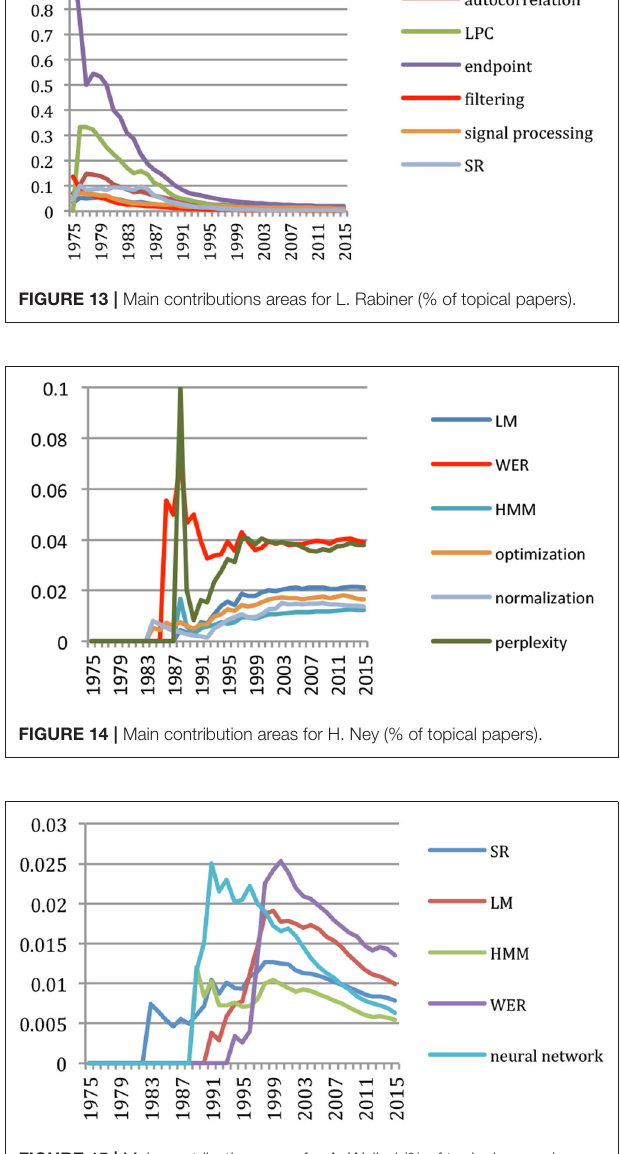
FIGURE 15 | Main contribution areas for A. Waibel (% of topical papers).